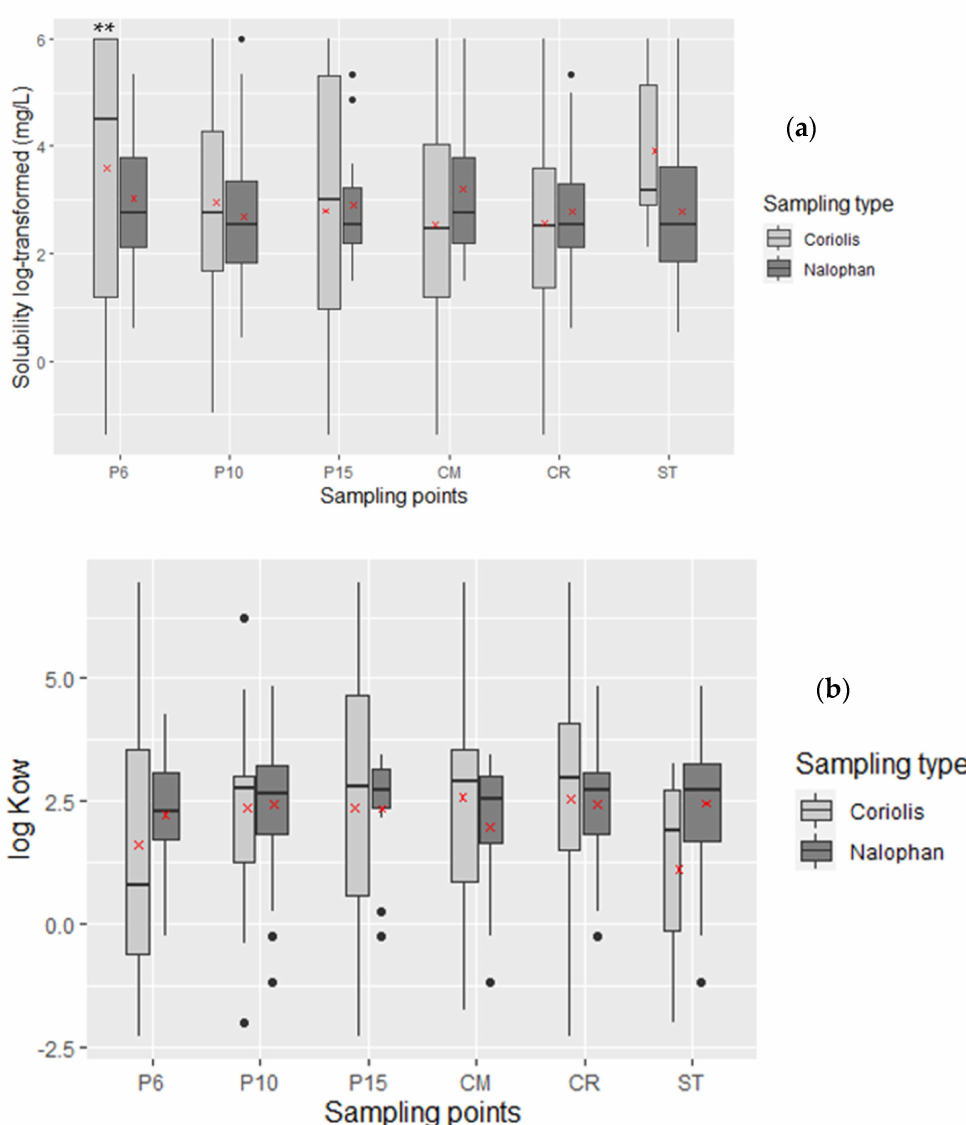
Figure 3. Comparison of: ( a ) solubilities in water at 25 ◦ C according to the sampler type used. The red crosses represent the mean values. No significant difference is found between these two variables except for P6; ( b ) the octanol/water partition coefficient according to the method used. No significant difference is found between these two variables. ** mean p value < 0.01. Black dott represents an outlier value of the